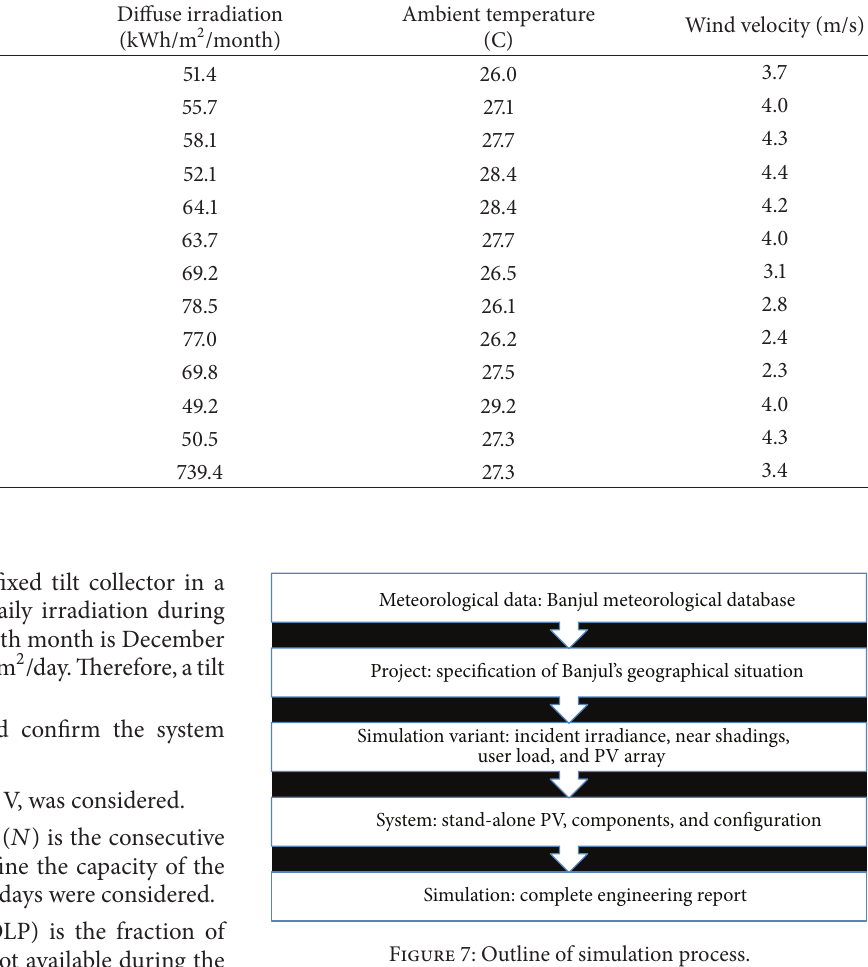
Figure 7: Outline of simulation